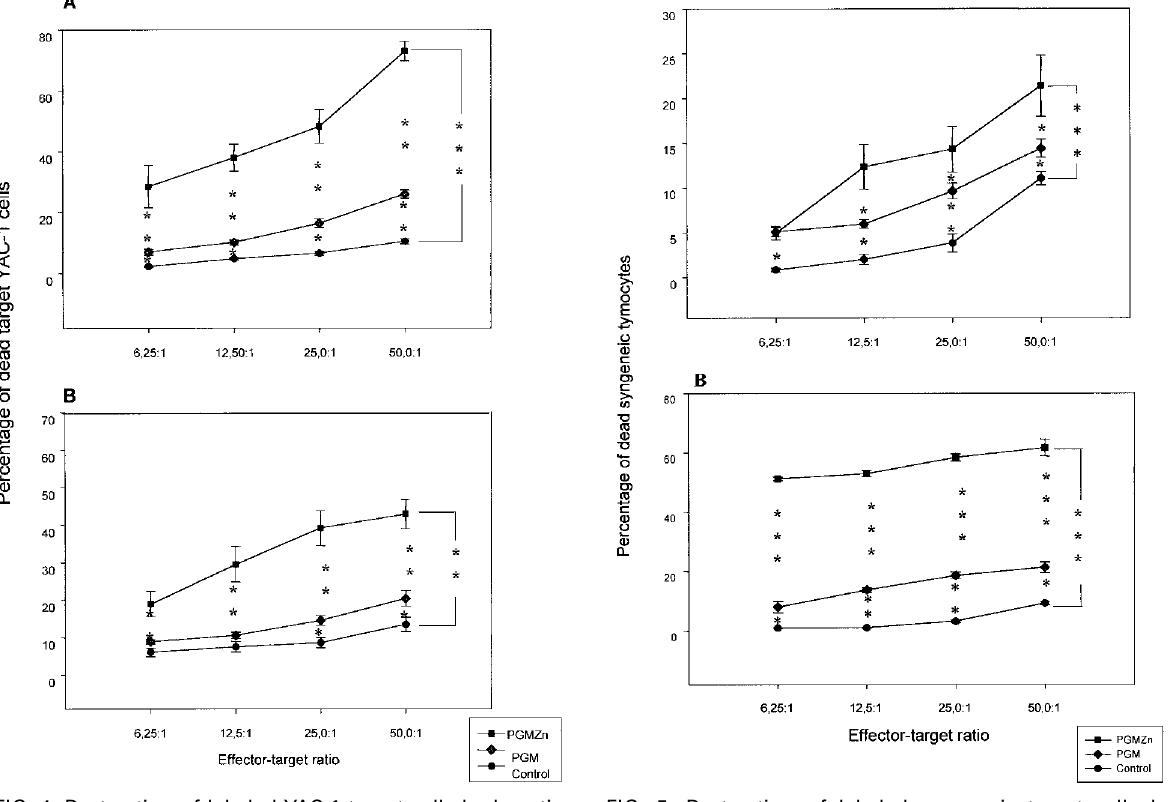
FIG. 4. Destruction of labeled YAC-1 target cells by hepatic (A) and splenic (B) MNLC obtained from mice pretreated with PGM-Zn or saline solution. Results are presented as mean ± standard error ( n = 7). * p < 0.05, ** p < 0.01, *** p < 0.001.